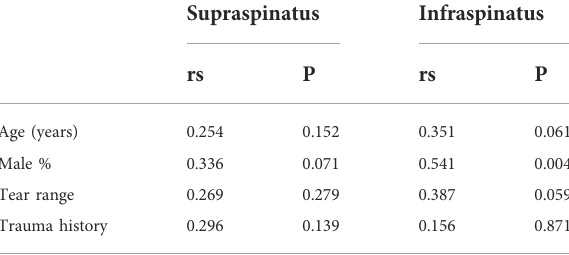
TABLE 4 Correlation analysis of the average Goutallier grade of supraspinatus muscle and infraspinatus muscle in the crescent/ U-shaped tear